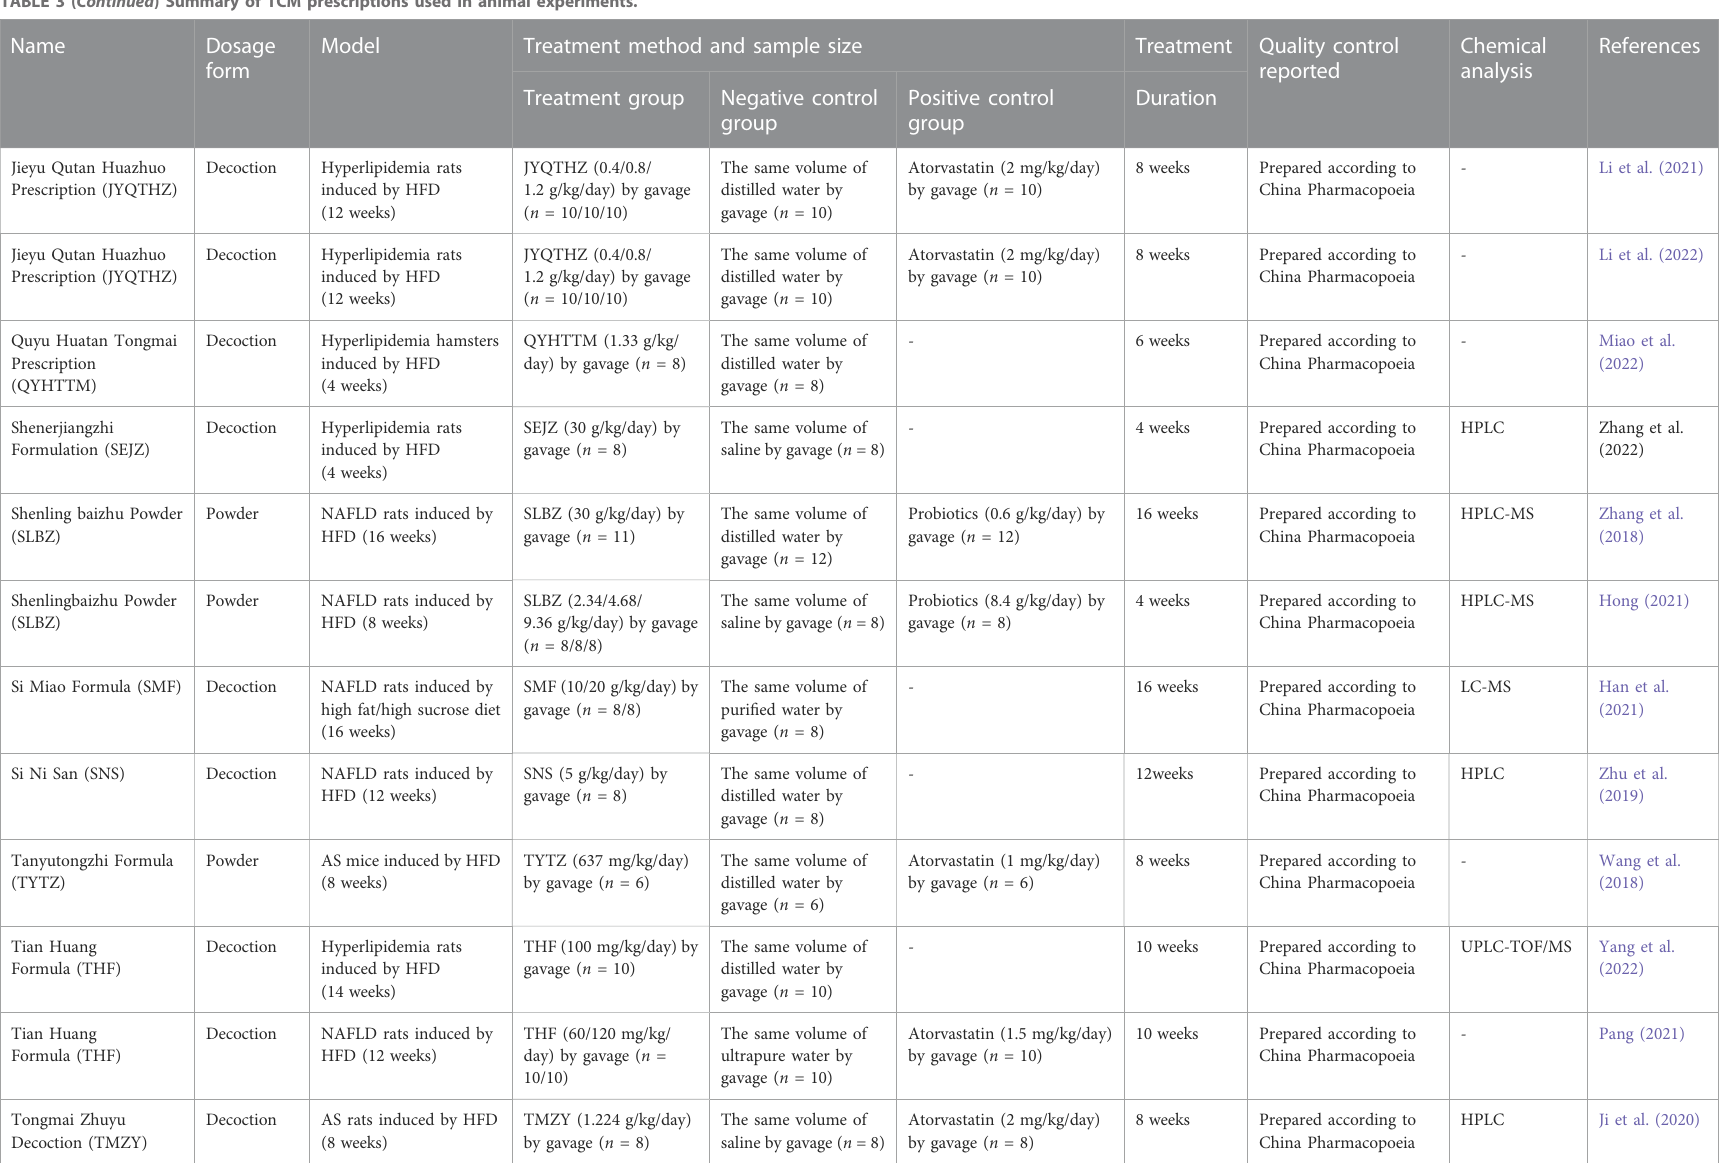
TABLE 3 ( Continued ) Summary of TCM prescriptions used in animal